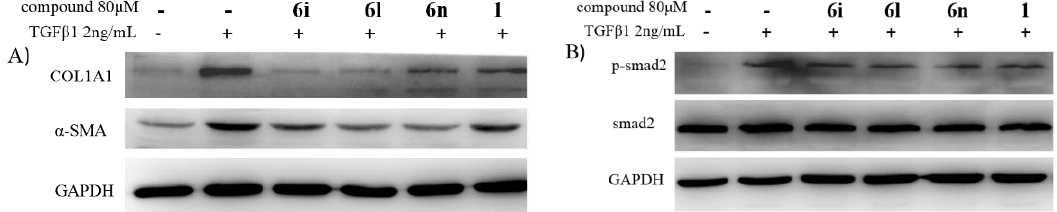
Figure 3. ( A ) Effects of compounds 6i , 6l and 6n on inhibiting fibrogenetic COL1A1 and α-SMA protein levels in LX-2 cells; ( B ) Effects of compounds 6i , 6l and 6n on p-smad2 and smad2 levels in LX-2 cells. Data were analyzed by western blot assay. The protein expression levels were normalized against GAPDH.